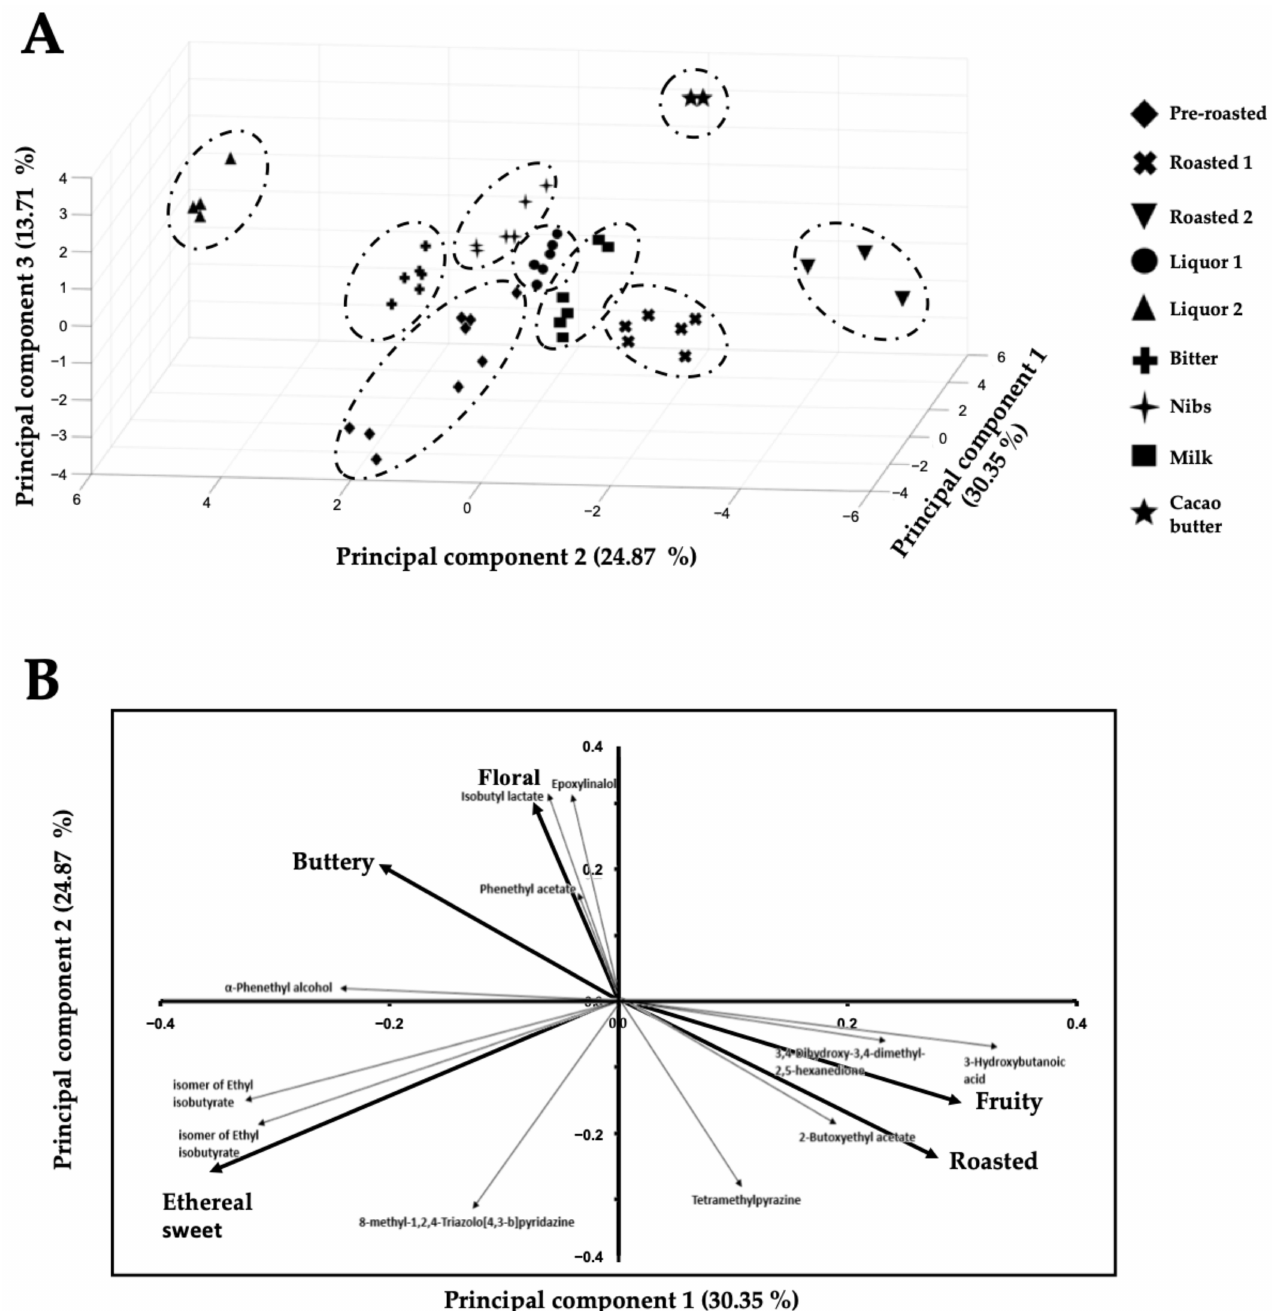
Figure 2. ( A ) 3D—Principal component analysis of key stages of chocolate elaboration and ( B ) Loading plot of the 3D— Principal component analysis of key stages of chocolate elaboration based on ( A ) the eleven key volatile organic